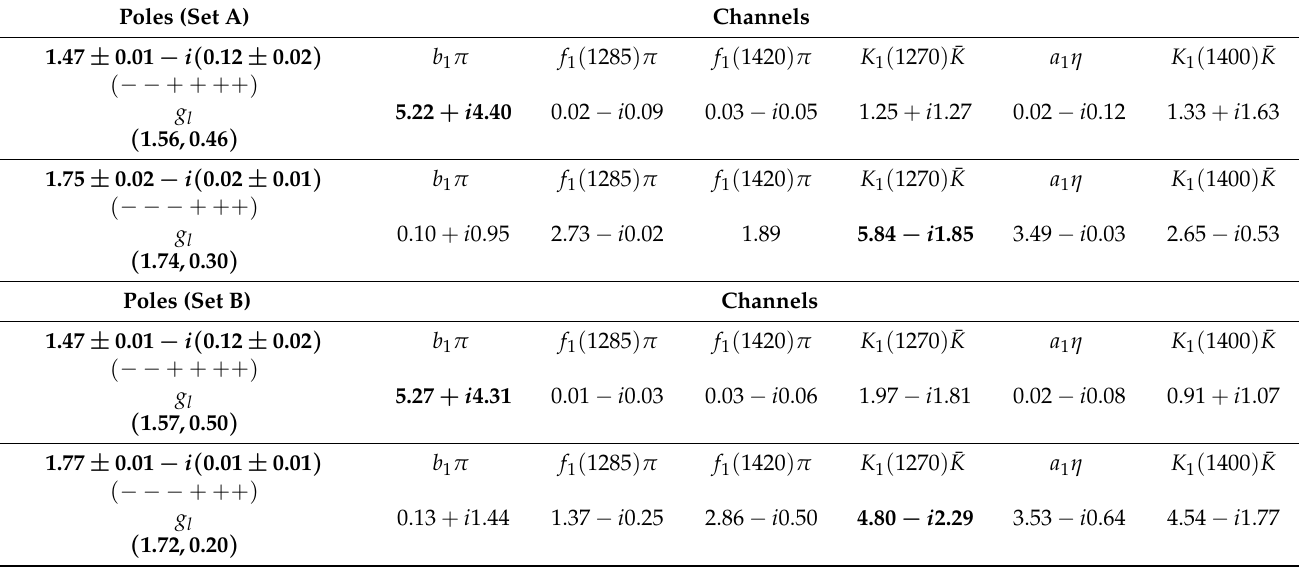
Table 11. Poles and their corresponding couplings to the channels contributing to the PA interaction with J PC = 1 − + and I = 1. The dominantly coupled channel is emphasized in boldface for each pole. The errors of the poles are from varying the subtraction constant within α ( µ = 1GeV ) = and only the central values of the couplings are given. The last row of each panel gives the central values of the peak mass and width ( M peak , Γ peak ) for the corresponding pole after considering the axial-vector meson